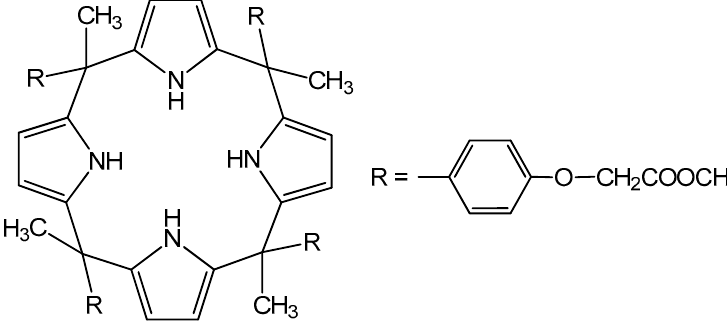
Figure 9. Structures of meso -tetra methyl tetrakis-[methyl-2-(4-acetlphenoxy)] calix[4]pyrrole (KP).